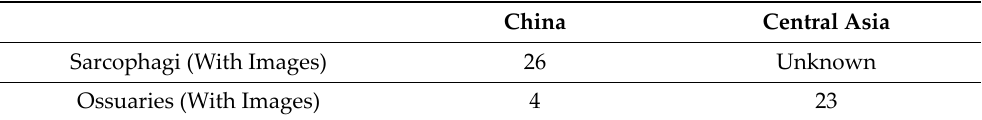
Table 1. Statistics of the Sogdian Burial Utensils with Images. China Central Asia Sarcophagi (With Images) 26 Unknown Ossuaries (With Images) 4